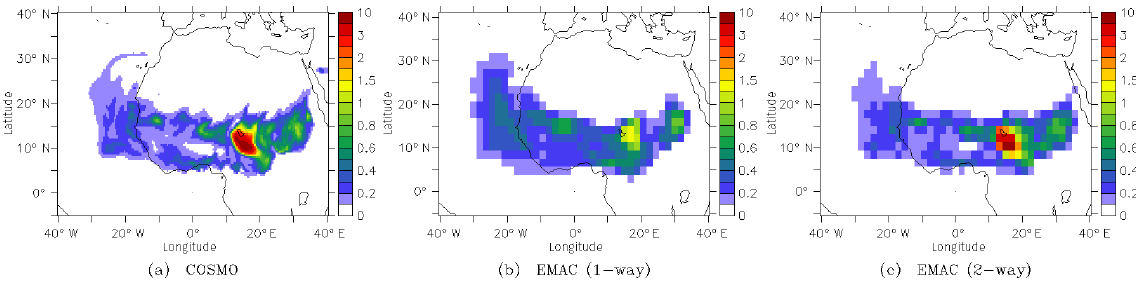
Figure 9. Dust column mass (mgm 2 ). Shown is an instantaneous value for 6 March 2004, 00:00UTC. (a) For COSMO/MESSy; (b) for EMAC; (c) for two-way coupled EMAC, thus influenced by the COSMO/MESSy